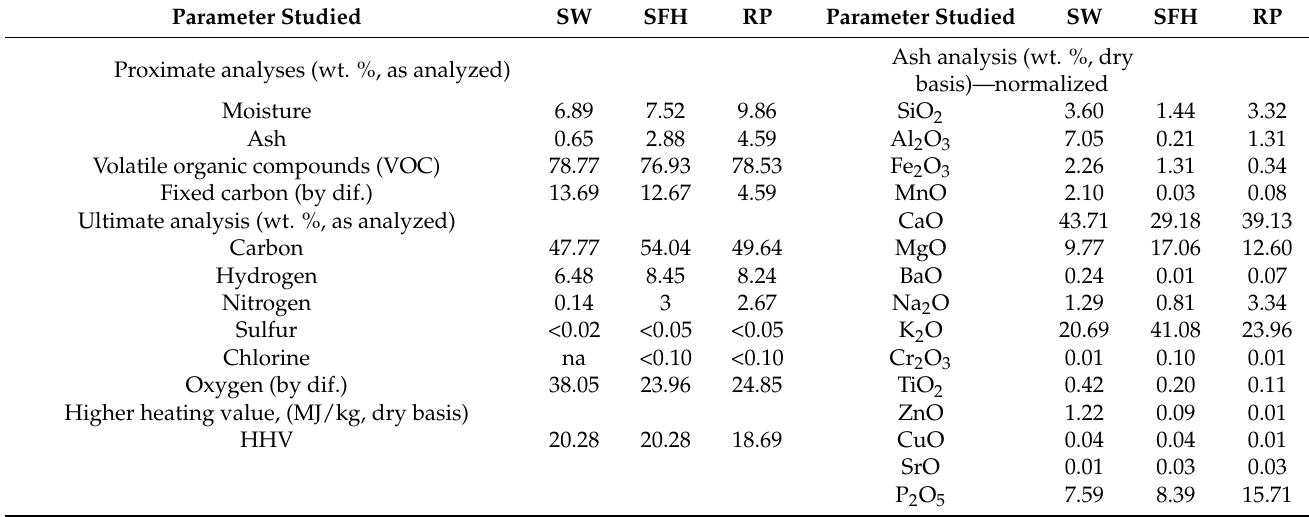
Table 1. Chemical characteristics of the used biomass, as reported elsewhere